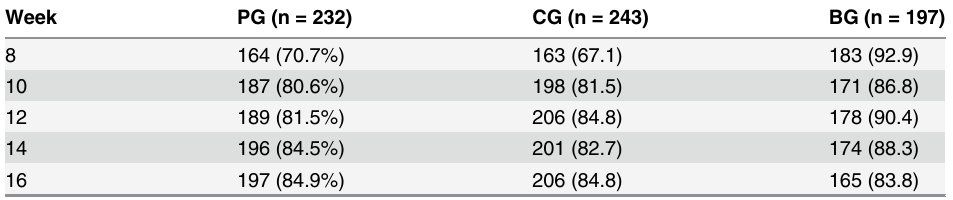
Table 1. Exclusive study formula and exclusive breastfeeding per 2 week time point in the first 16 weeks of life.